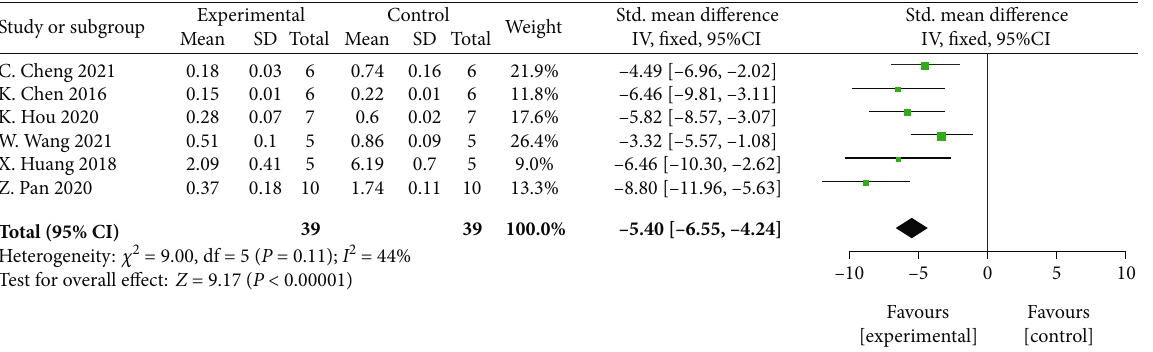
Figure 6: The forest plot: e ff ects of MSCs-derived sEVs for reducing the level of caspase-3 compared with control